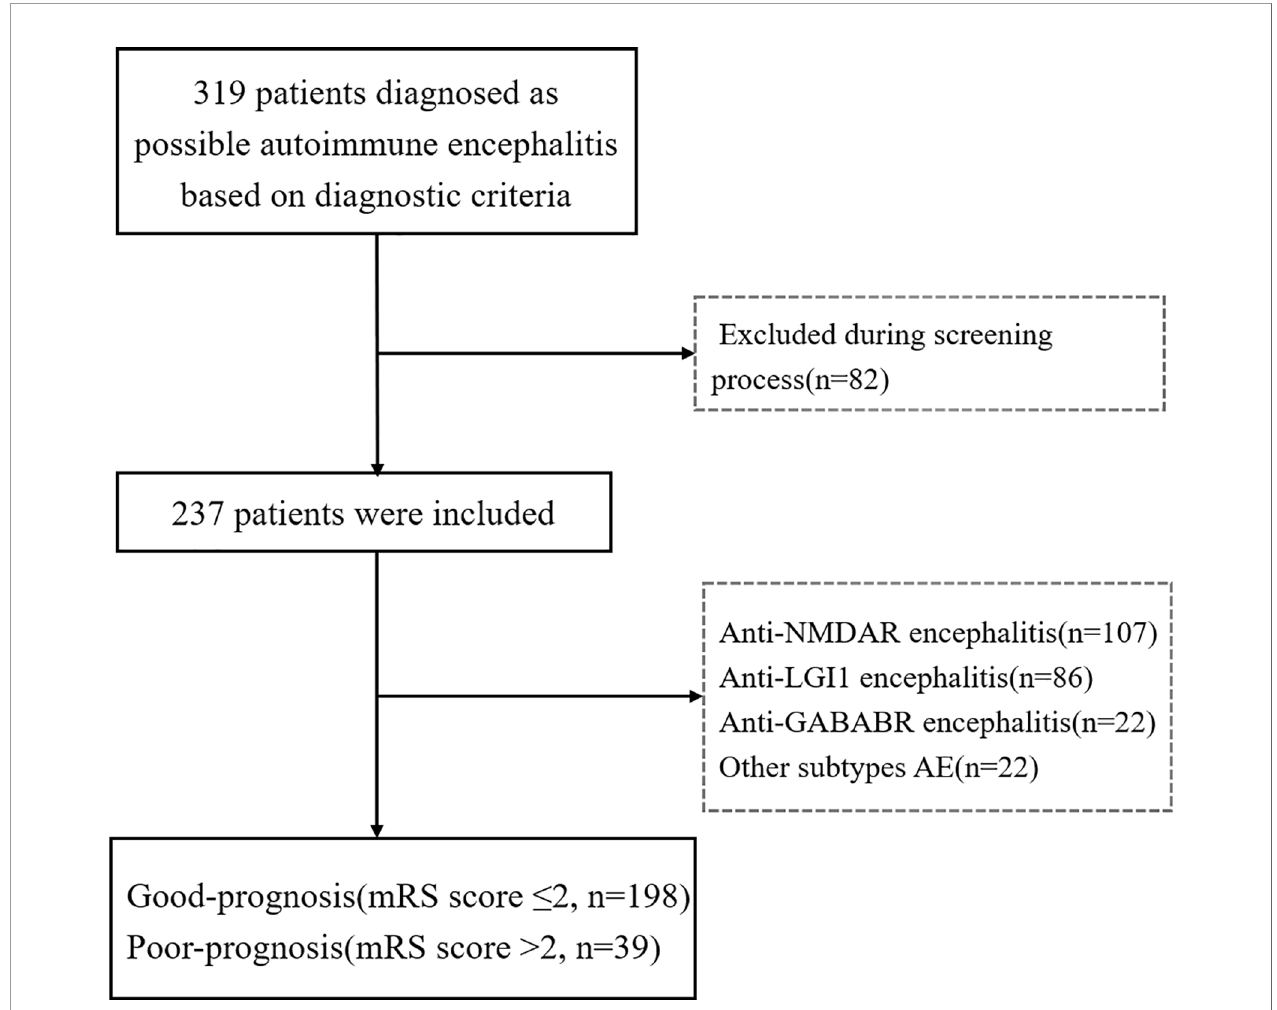
FIGURE 1 | The fl owchart of patient recruitment. mRS, modi fi ed Rankin